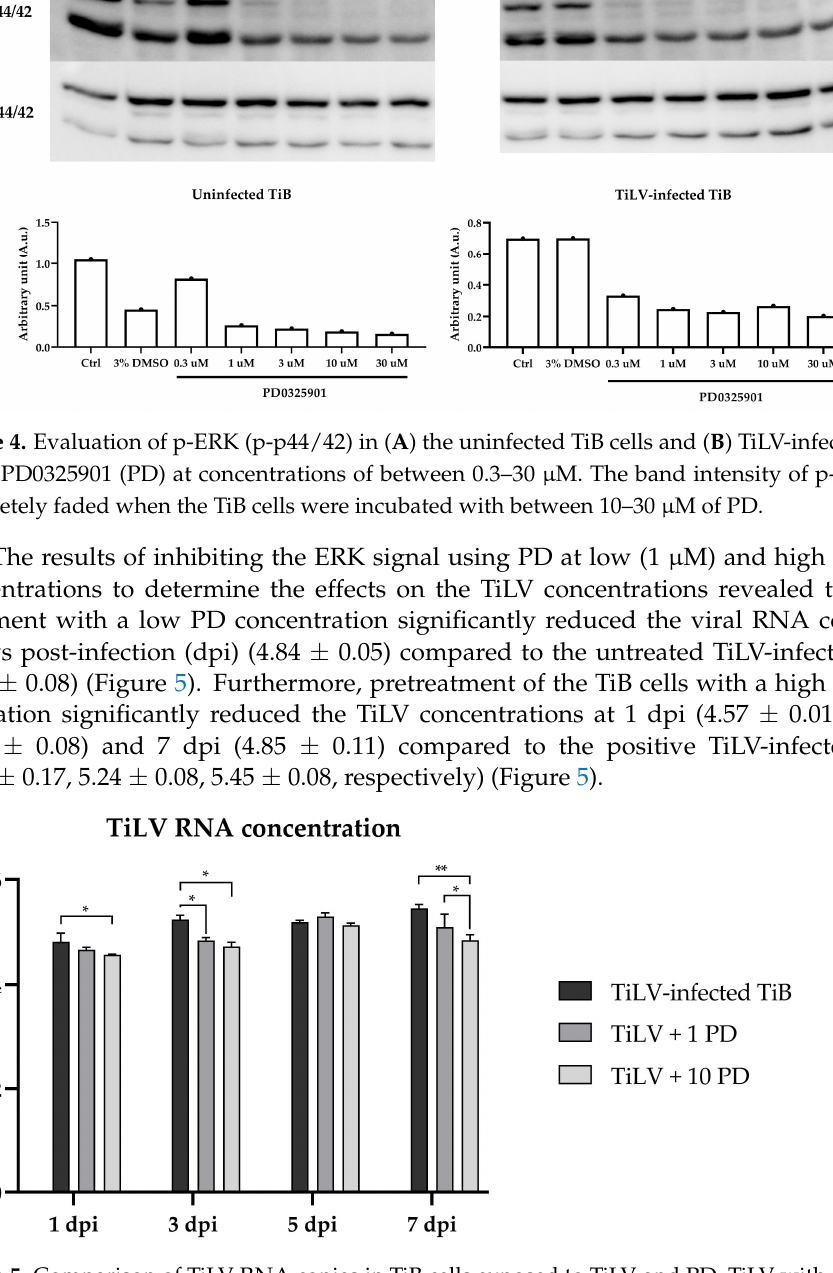
Figure 3. The determination of ERK phosphorylation (p-ERK) in ( A ) the E − 11 cells and ( B ) TiB cells